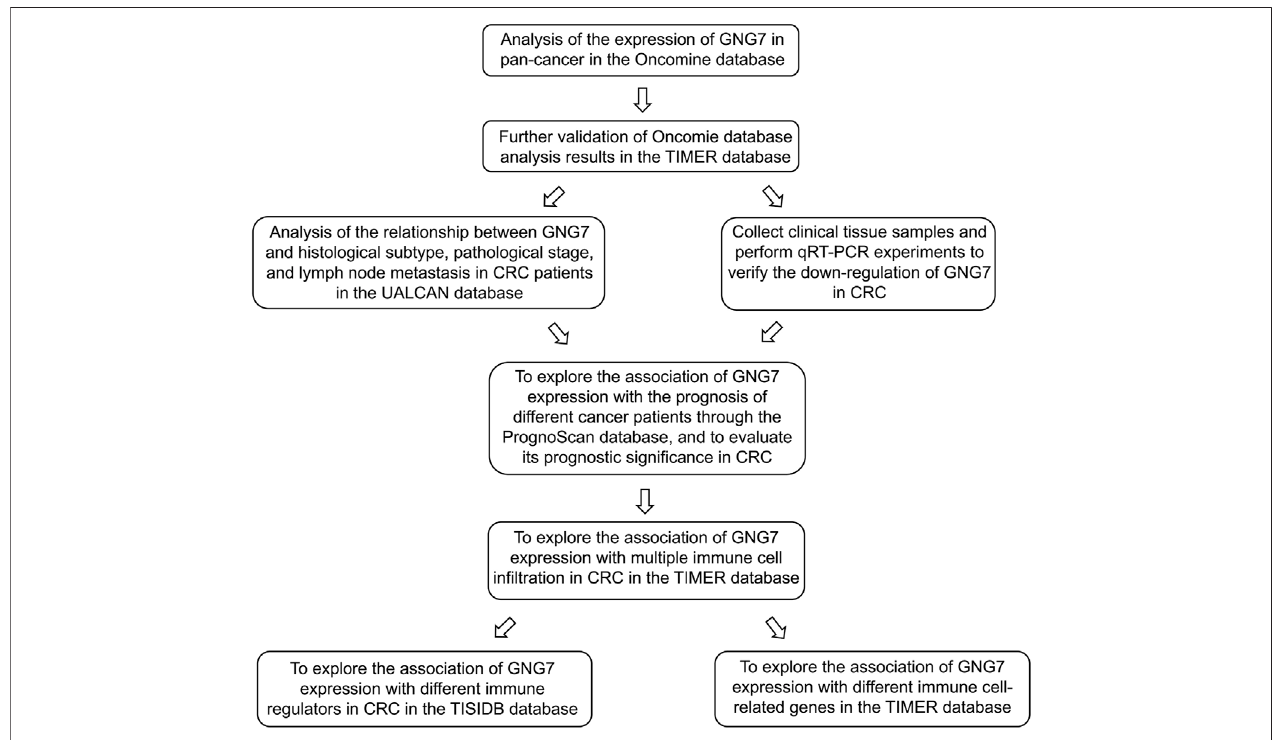
FIGURE 2 | The basic analysis process of this study.